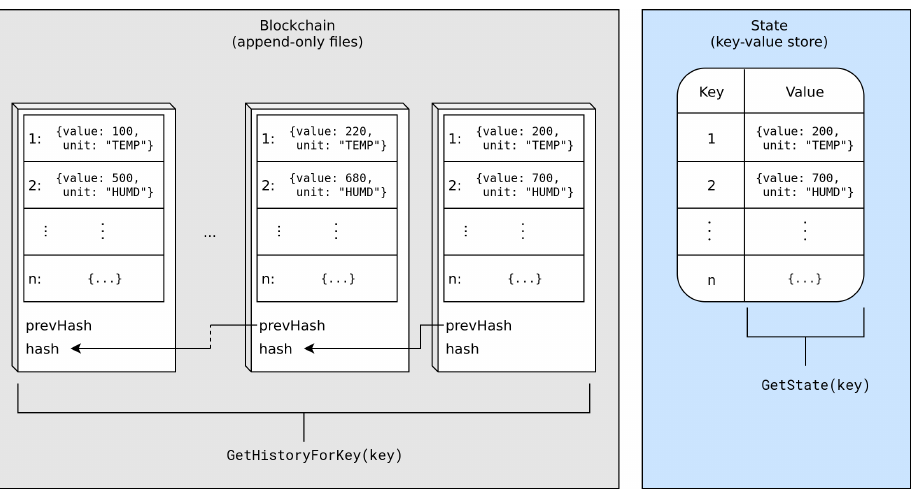
Figure 1. The Fabric’s ledger, where the state is determined by sequentially applying transactions stored in the blockchain.